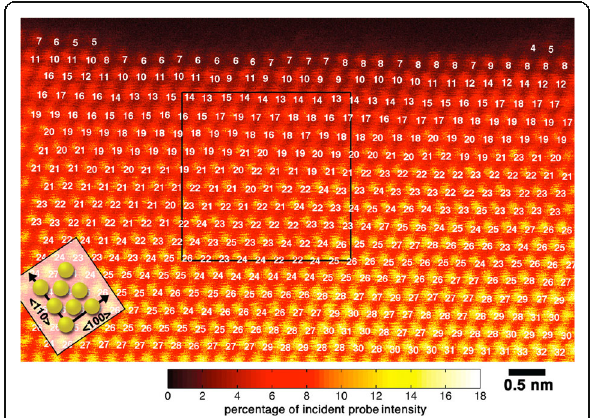
Fig. 5 HAADF-STEM image of a wedge-shaped gold film viewed along 〈 110 〉 . The intensity maxima correspond to gold atom columns, and the white labels near the lower right of each atom column indicate the number of atoms contained in that column. The black box outlines the region from which the PACBED pattern shown in Fig. 3 was obtained. The image intensities are shown on